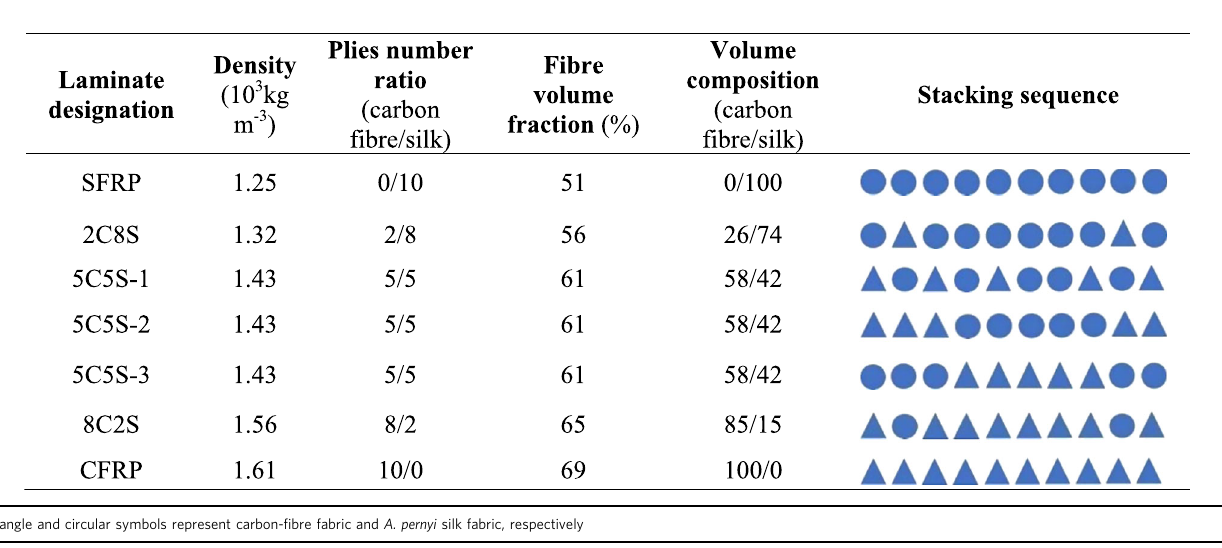
Table 2 The design parameters of composite laminates with different hybrid ratios and stacking